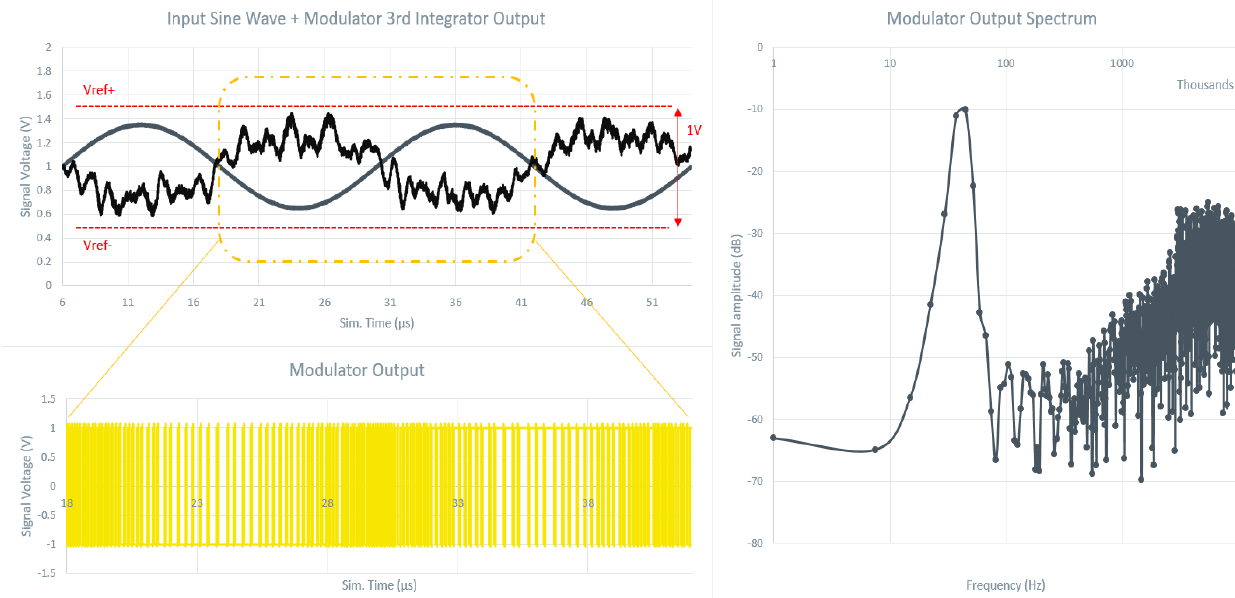
Figure 13. Transient-Noise simulation of the free-running operation of the converter modulator.